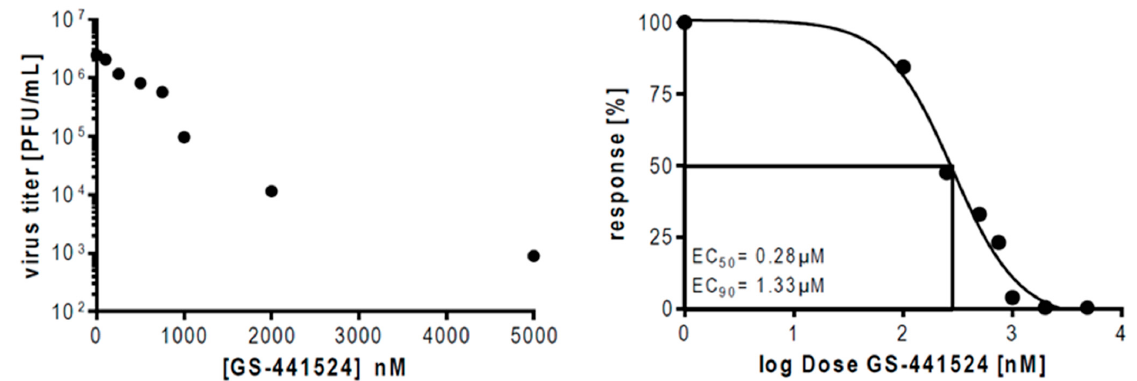
Figure 1. Analysis of GS-441524-mediated reduction of infectious SARS-CoV-2 particle production. Polarized Calu-3 cells were infected with 0.1 MOI of SARS-CoV-2 (hCoV-19/Germany/FI1103201/2020) for 48 h. At 2 hpi, cells were treated with GS-441524 at the indicated concentrations. Data were expressed as mean infectious viral titers ± SEM or as mean percent inhibition ± SEM of SARS-CoV-2 replication (control cells that were treated with the solvent DMSO were set to 100%), n = 5. LogEC 50 and LogEC 90 values were determined by fitting a four-parameter non-linear regression model.